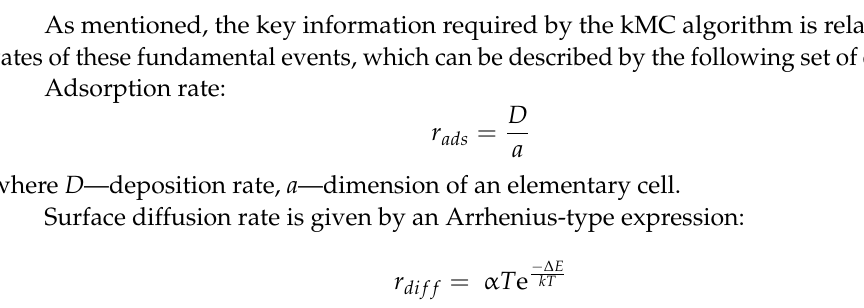
Figure 1. Elementary events during the PLD accounted for by the developed kMC model.